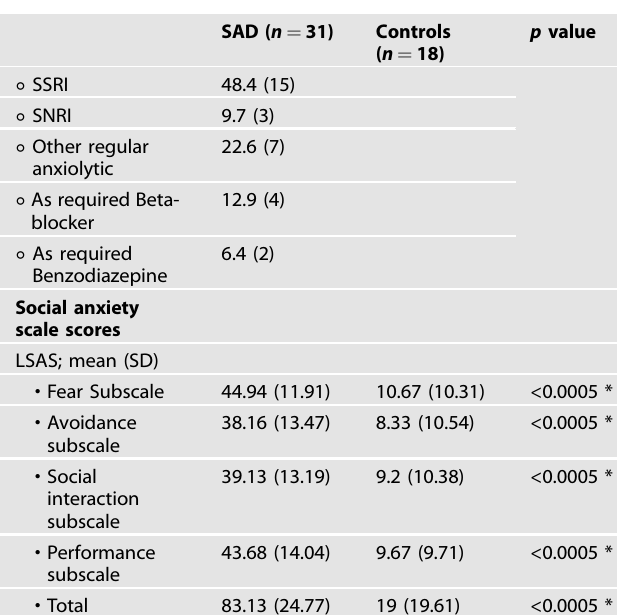
BMI Body Mass Index, GAD Generalised Anxiety Disorder, IPAQ International Physical Activity Questionnaire, LSAS Liebowitz Social Anxiety Scale, MDD : Major Depressive Disorder, PSQI Pittsburgh Sleep Quality Index, SAD Social Anxiety Disorder, SD Standard Deviation, SNRI Serotonin and Norepinephr- ine Reuptake Inhibitor, SSRI Selective Serotonin Reuptake Inhibitor p values based on Fisher ’ s exact test for categorical variables and Student ’ s T-tests for all continuous variables apart from alcohol (units per week) which was a nonparametric Mann-Whitney U test. p-values reaching statistical signi fi cance are accompanied by an